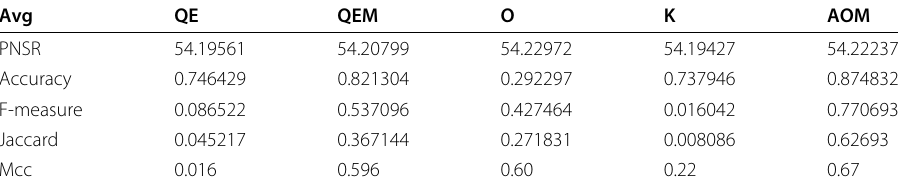
Table 1 average of PSNR, accuracy, F-measure, Jaccard and MCC for quantum entropy, quantum modified entropy(proposed), Otsu, Kapur method, and the hybrid methods respectively Avg